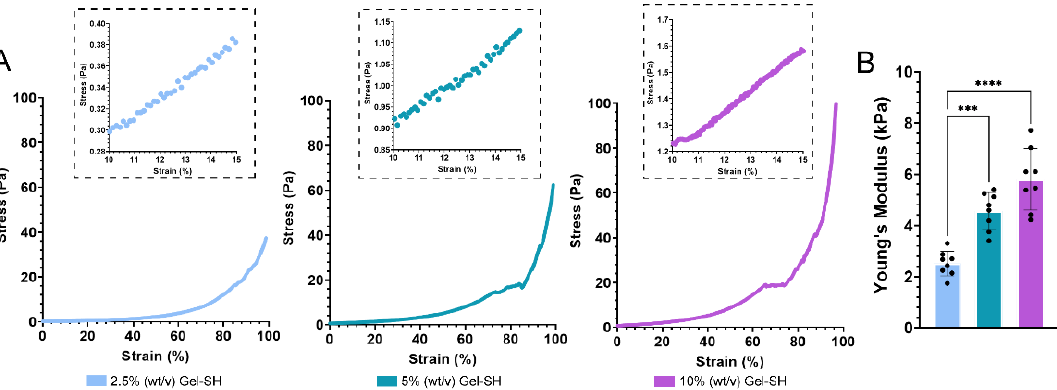
Figure 5. Compression testing of Gel-SH/PEG-4MAL hydrogels. ( A ) Stress–strain curves of Gel- SH/PEG-4MAL hydrogels, n = 1. ( B ) Young’s modulus of Gel-SH/PEG-4MAL hydrogels determined using hydrogel height, area, and slope of stress–strain curves at 10–15% strain ( n = 8; mean ± SEM; *** = p ≤ 0.0001, **** = p ≤ 0.0001.